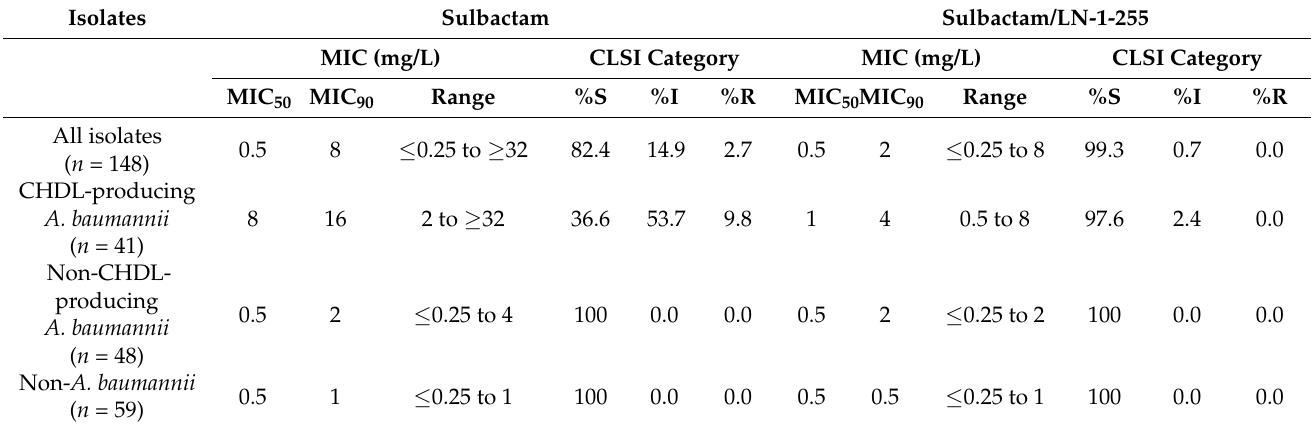
Table 5. Susceptibility of Acinetobacter spp. isolates to sulbactam and